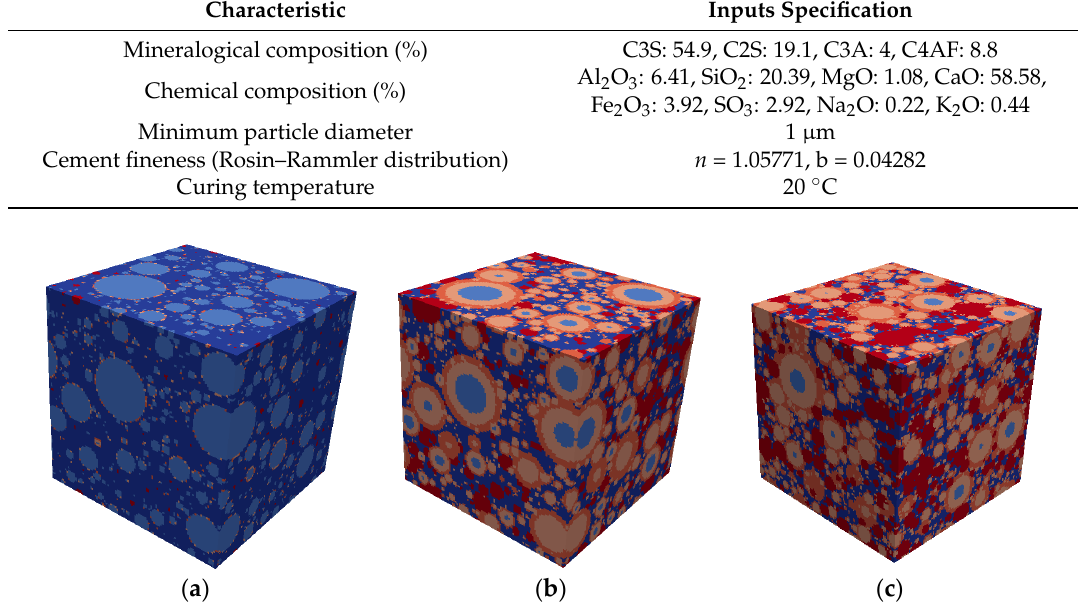
Figure 7. Simulated microstructures of cement paste for specimen size 100 μ m × 100 μ m × 100 μ m: At ( a ) 3 h; ( b ) 28 d; and ( c ) 169 d (porous in dark blue, unhydrated cement in bright blue, inner hydration product in bright orange, outer hydration product in dark orange, and CH-calcium hydroxides in red).